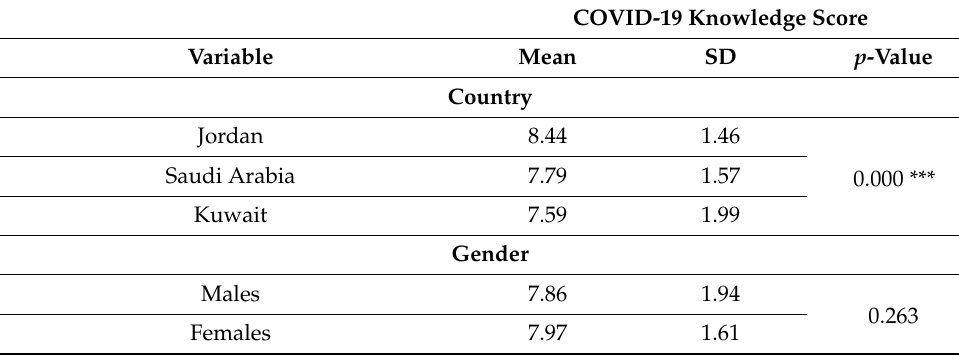
Table 4. COVID-19 knowledge score by participants’ characteristics ( n =